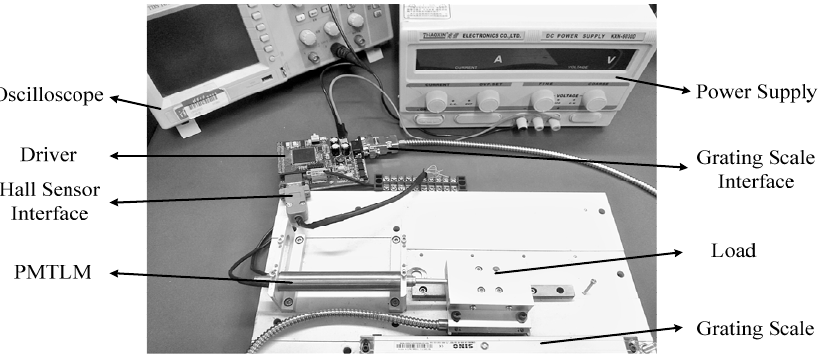
Figure 6. Experimental platform.